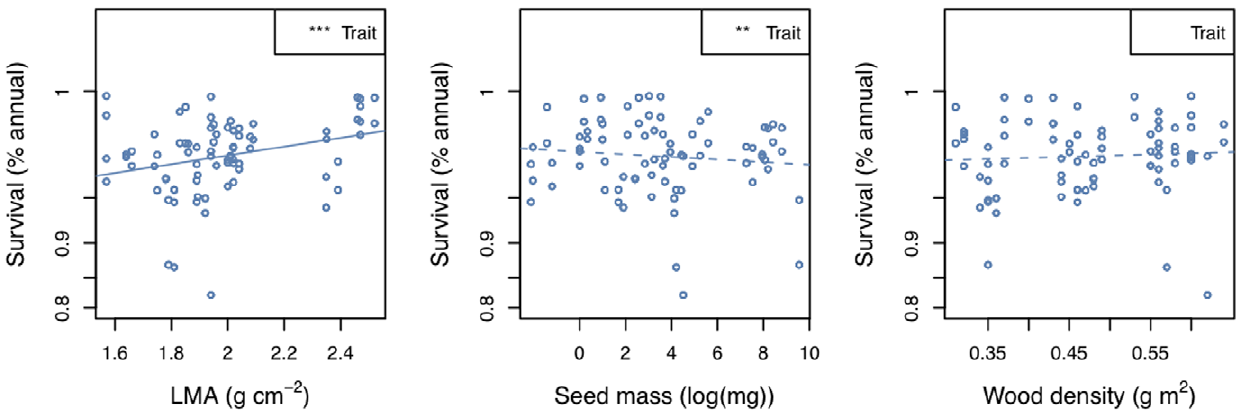
Figure 2. Survival versus functional traits. Leaf mass per area (LMA) shows a positive slope, indicating that species with thicker leaves tend to survive more, as predicted by theory. Seed mass and wood density show weak or no relationship to survival. ANOVA table details in Table 1.